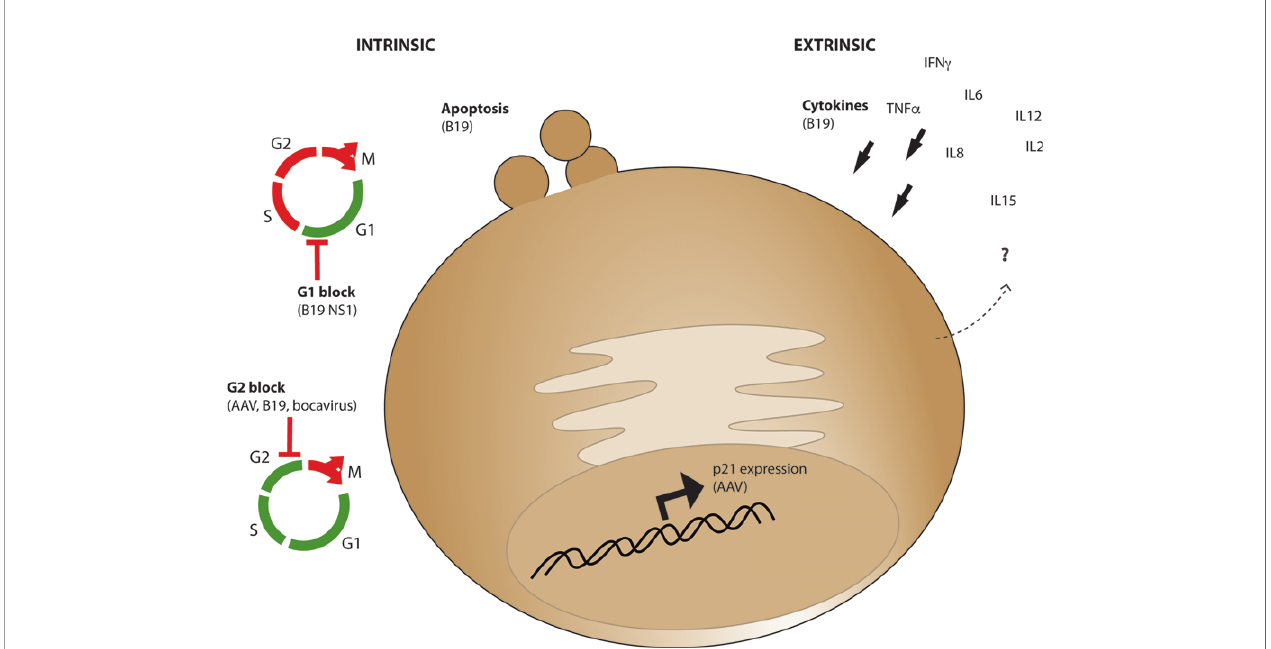
FIGURE 4 | Intrinsic and Extrinsic parvoviral effects which may in fl uence CD34+ cell survival and functionality. Intrinsic cellular effects (left) observed from AAV or other parvoviruses include apoptosis, G1 cell cycle arrest through B19 parvovirus NS1 expression, or G2 cell cycle block from AAV, B19, and bocavirus genomes. Extrinsic effects (right) observed from parvovirus B19 infection include expression of cytokines which promote CD34+ cell differentiation including IL6, which are expressed from various cell types in vivo during acute and chronic